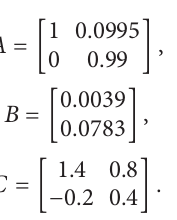
Figure 3: Values of 𝛼(𝑘)